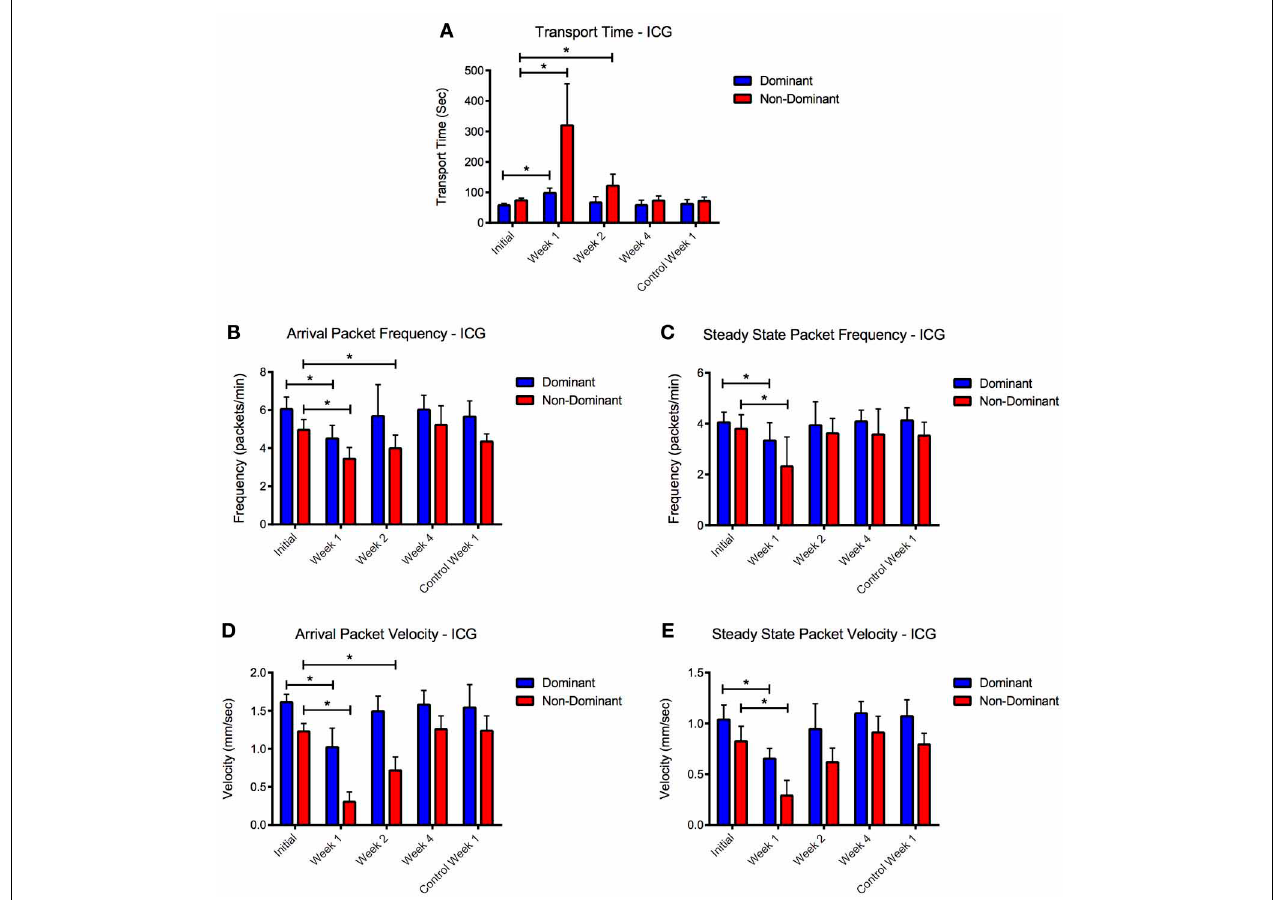
steady-state periods for dominant and non-dominant vessels during the four time points and for the control animals at week 1. Error bars represent standard deviation. ∗ p < 0 . 05.